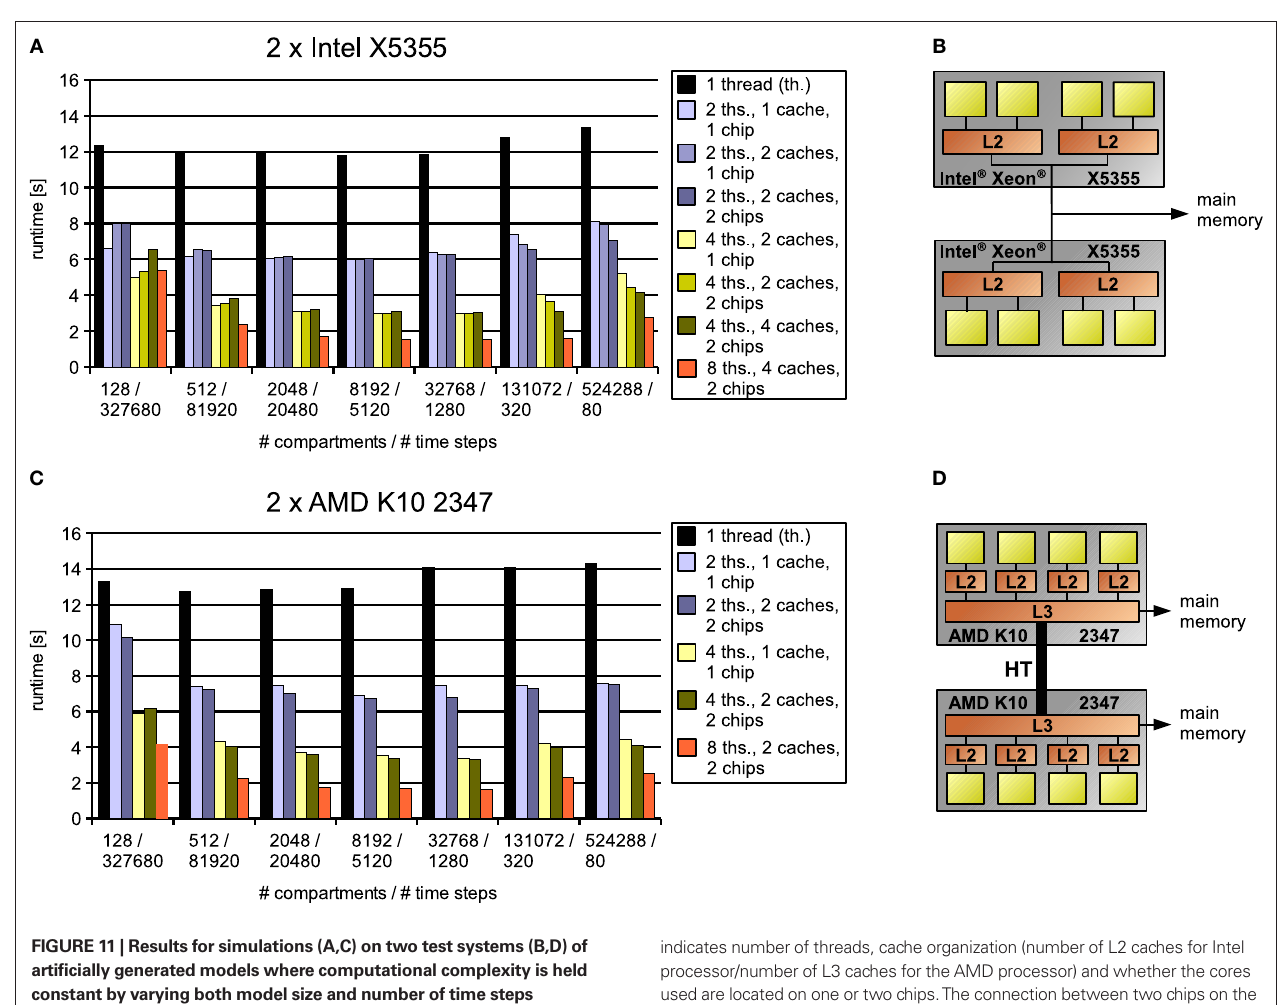
indicates number of threads, cache organization (number of L2 caches for Intel processor/number of L3 caches for the AMD processor) and whether the cores used are located on one or two chips. The connection between two chips on the AMD system (D) is illustrated by a thick line modeling the HyperTransport interconnect (HyperTransport Consortium,